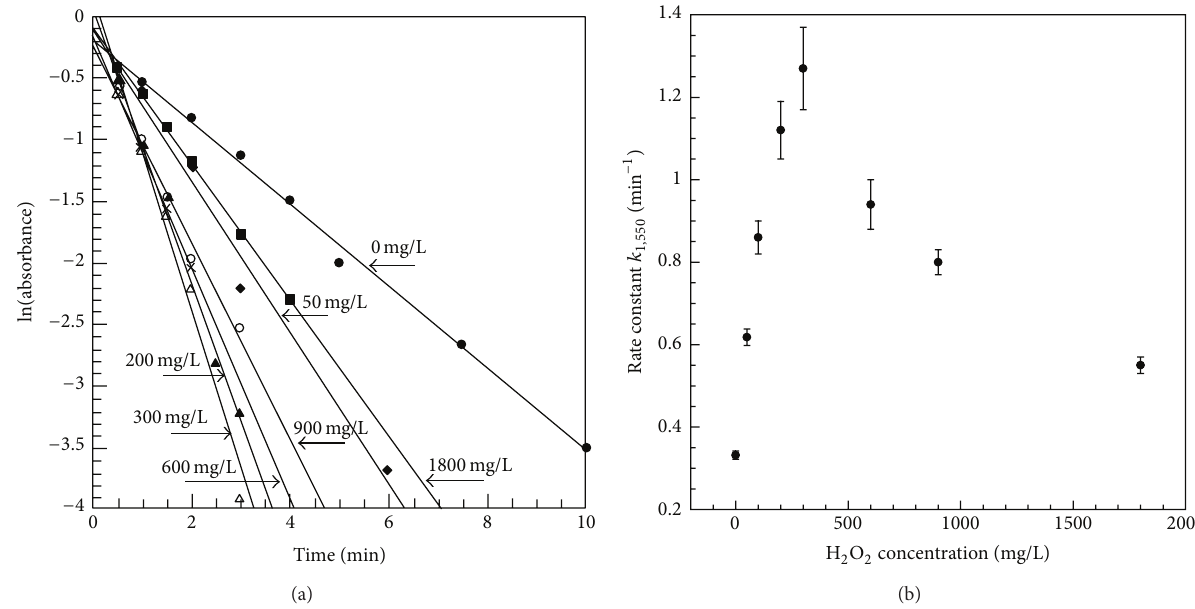
Figure4:(a)SemilogarithmicplotoftheabsorbanceofRhBsolution(10.2mg/L)at554nmversustimeatvariousinitialH 2 O 2 concentrations, with 𝑃 = 30 ± 0.5 W and 𝑇 = 40 ± 1 ∘ C (filled circles: 0 mg/L, filled diamonds: 50 mg/L, filled triangles: 200mg/L, open triangles: 300 mg/L, crosses: 600mg/L, open circles: 900mg/L, and filled squares: 1800 mg/L). (b) Apparent rate constant 𝑘 1,554 of decoloration of RhB aqueous solution (10.2mg/L) as a function of [H 2 O 2 ] 0 , with 𝑃 = 40 ± 0.5 W and 𝑇 = 40 ± 1 ∘ C, obtained from data of